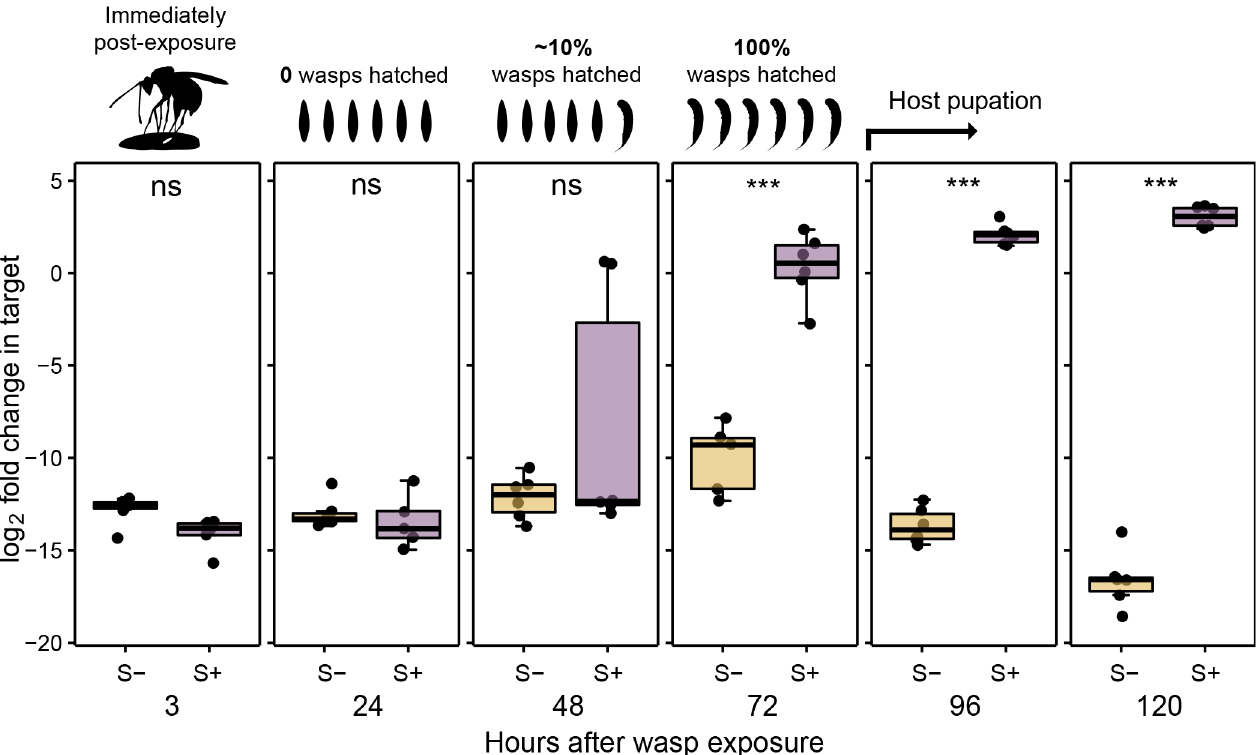
Fig 2. Hallmarkof RIP attackin wasps begins soon after hatching. Abundanceof depurinated ribosomesacross a timecourse of L . heterotoma infestationof D . melanogaster in the presenceand absenceof s Mel(n = 6 fly larvae or pupaeper timepoint). Jitter points are the meanof two technicalreplicatesper wasp-infested larva. Depurinated L . heterotoma ribosomesare detected48 hours after ovipositionin s Mel-positive D . melanogaster , with increasinglevelsat subsequenttimepoints.For all significantcomparisons, p < .001 (t-tests). Legendsaboveboxplotsindicate parasiticwasp developmental stage at each time point